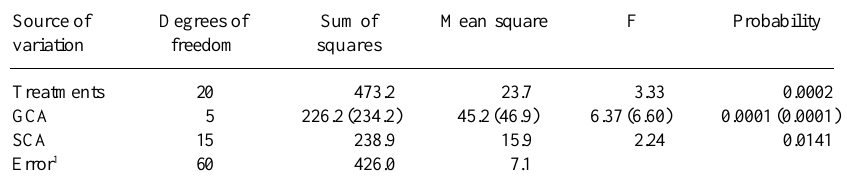
Table II - Analyses of variance of grain yield (bushels/acre) of six corn populations and their hybrids, based on the model with restrictions that satisfy the genetic parameter values and the Griffing (1956b) model (values in parentheses for general combining ability, GCA).